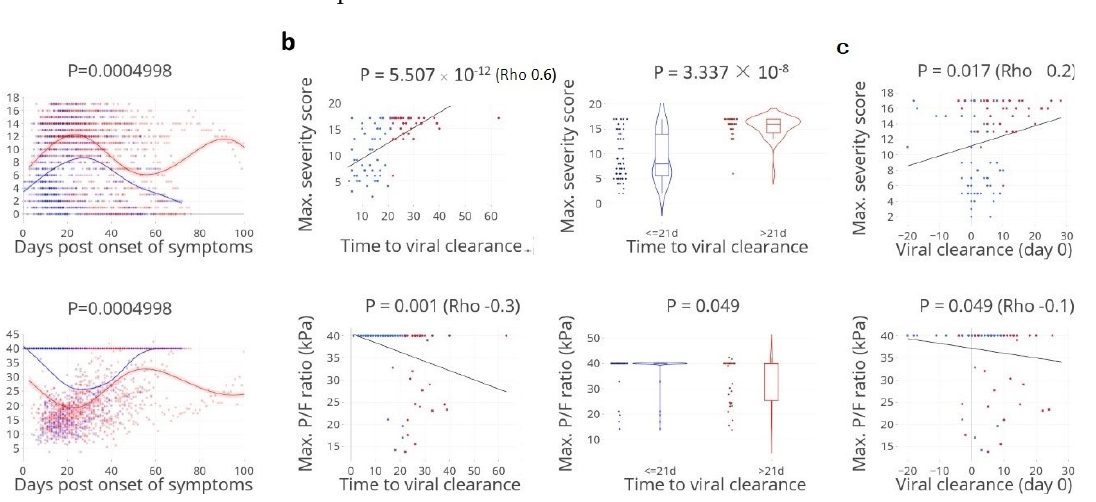
Figure 1. Time to viral clearance correlates with disease severity. ( a ). Kinetics of daily clinical severity scores and PO 2 /FiO 2 (P/F) ratios: kinetics in relation to the time post onset of symptoms in days, per patient per groups with rapid: ≤ 21 days (blue lines/dots) and delayed: > 21 days viral clearance (red lines/dots). Lines indicate non-linear group trends. Spline regression with bootstrap confidence intervals, 39.9 kPa stands for the minimum disease severity. ( b ). The maximum (max.) daily clinical severity score and P/F ratio per patient in relation to time to viral clearance (days), defined as the last positive PCR. Spearman’s rank correlation (rho), and Mann–Whitney U test (violin plots). ( c ). Viral clearance precedes critical illness. Number of days between viral clearance (vertical line, day 0) in relation to the maximum severity scores and to P/F ratio, respectively. Viral clearance ≤ 21 days (blue lines/dots)/> 21 days (red lines/dot). Spearman’s rank correlation (rho), n = 91 patients.